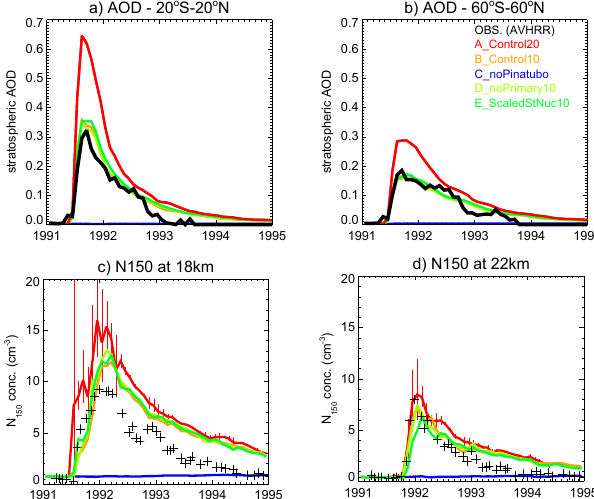
Figure 13. (a) Mean tropical (20 ◦ S, 20 ◦ N) and (b) near-global (60 ◦ S, 60 ◦ N) sAOD from AVHRR (550nm) and various model simulations (525nm). (c) and (d) show comparison between mod- elled and observed N 150 time series from Laramie (shown with + sign), at 18km and 22km,